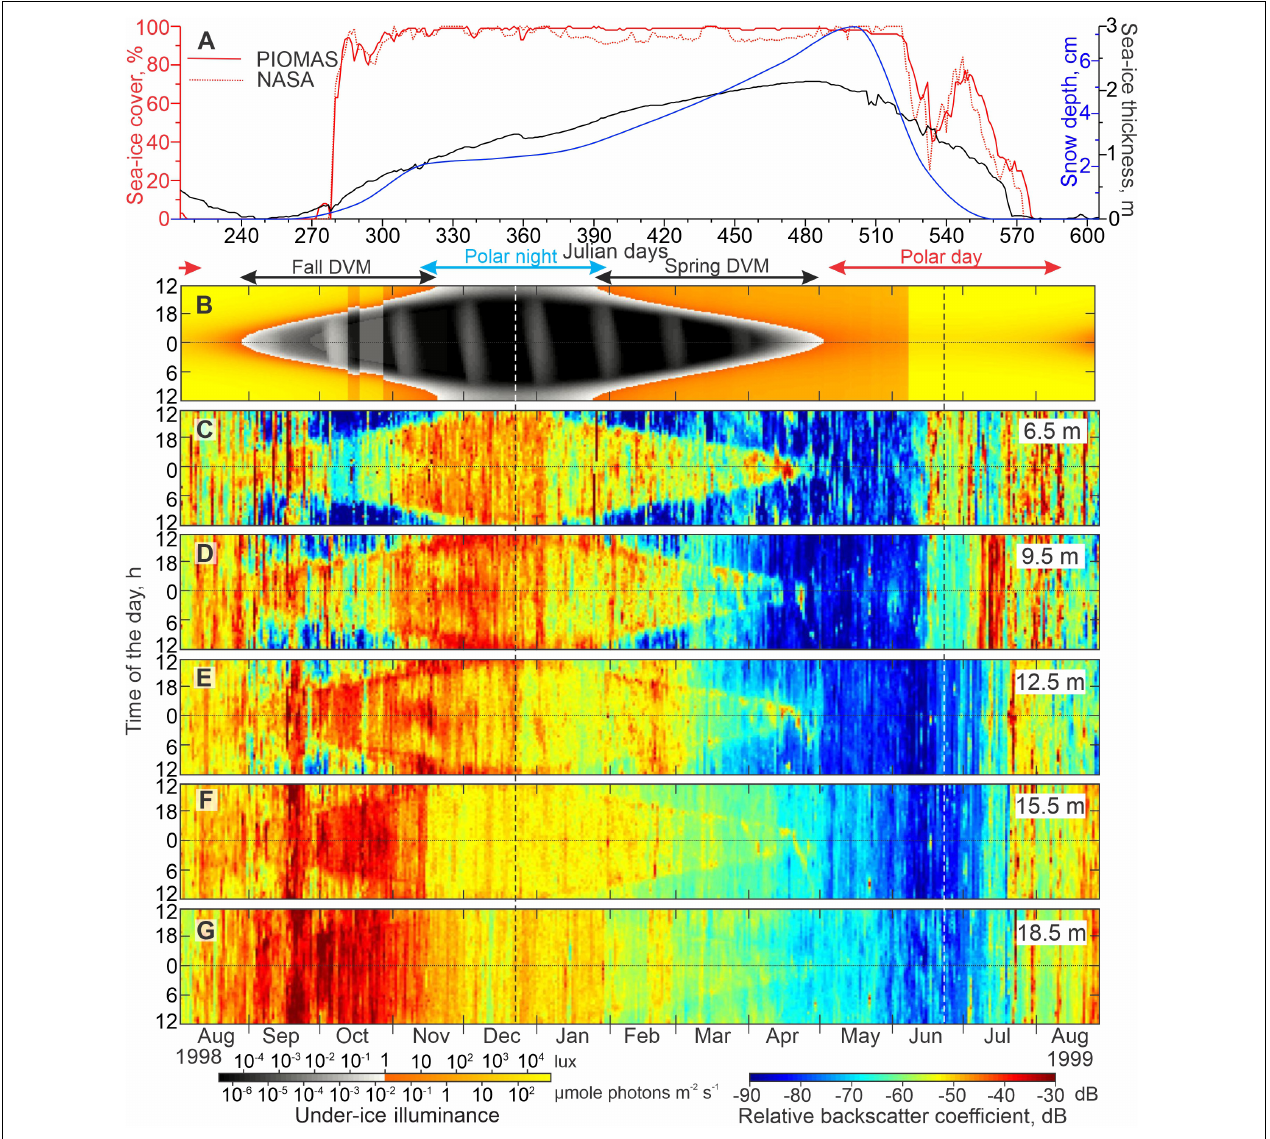
FIGURE 9 | Sea-ice, illuminance, and acoustic backscatter data for mooring Lena. (A) Time series of the snow depth (cm, blue), sea-ice thickness (m, black), and concentrations (%, red) from PIOMAS and NASA (solid and dotted lines, respectively). Actograms of (B) modeled under-ice illuminance (lux) and (C–G) MVBS (dB) at five depth levels: (C) 6.5, (D) 9.5, (E) 12.5, (F) 15.5, and (G) 18.5 m depth. All other designations are similar to those in Figure 8